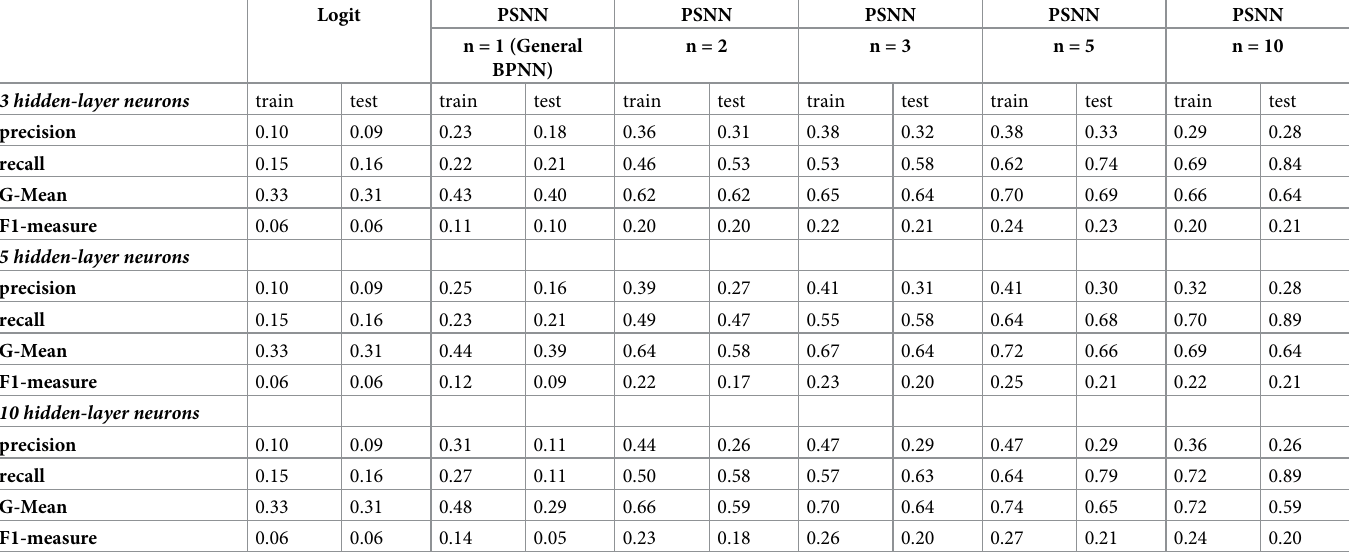
Table 7. Comparative experiment of unbalanced